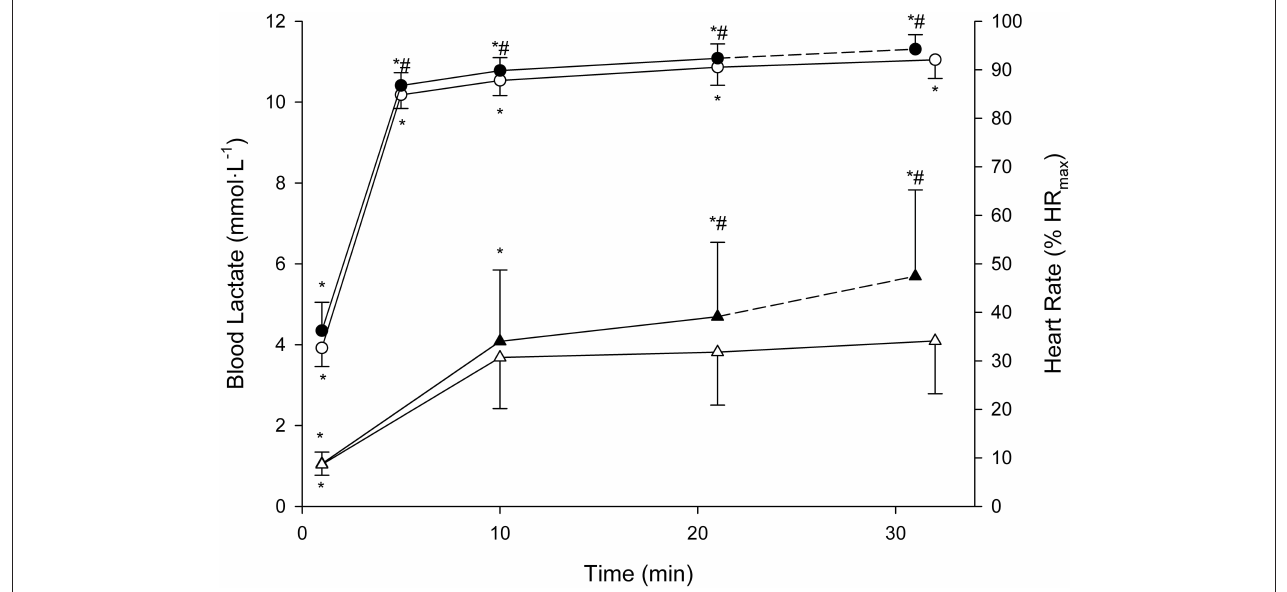
FIGURE 3 | Mean (SD) blood lactate (triangles) and heart rate (circles) responses to the constant running velocities tests (CVRTs) at the maximal lactate steady state velocity (open symbols) and at 0.2 km · h − 1 faster velocity (filled symbols). * Significantly different from the rest of the time-points within the same CVRT ( P < 0.0125). # Significantly higher in comparison with the corresponding time-points at the maximal lactate steady state velocity CVRT ( P < 0.0125).